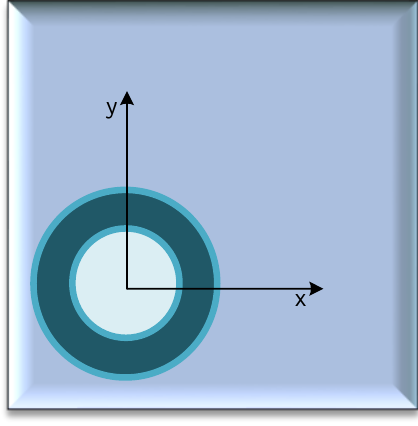
Figure 13. Transmitter with free positioning — moving the coil.